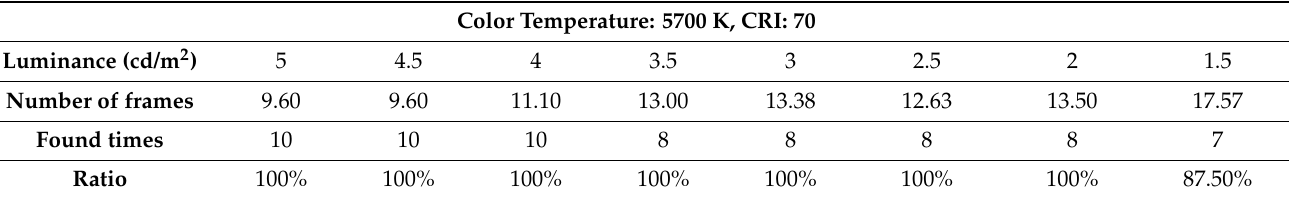
Table 3. Visual recognition under different luminance levels. Color Temperature: 5700 K, CRI: